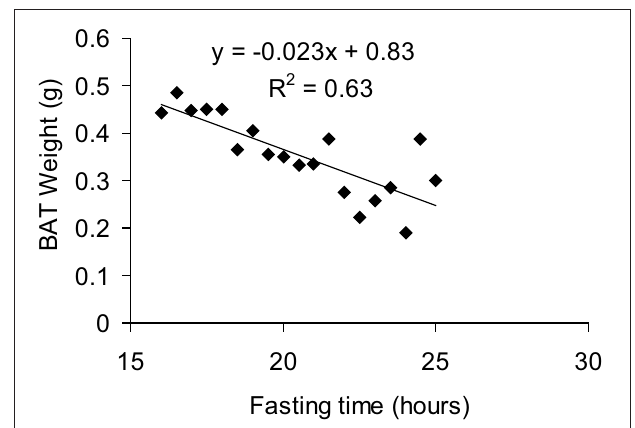
FIGURE 5 | Correlation between BAT weight and fasting time. All mice were fasted overnight for 15h and then dissected over a period of 8h, giving a total fasting time ranging from 16 to 24h for the animals studied. Mice were 7 months old, C57Bl/6 males fed a 60% HFD and acclimated to 5 ◦ C for at least 3 weeks prior to